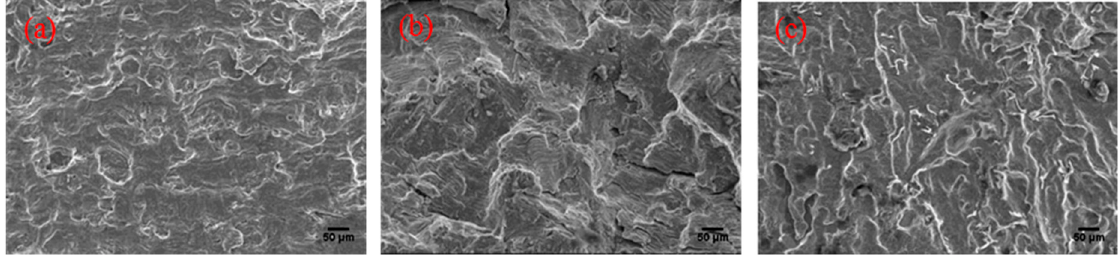
Figure 9. SEM morphology of longitudinal weld fusion line crack ( a ) initial crack zone; ( b ) propagation zone and ( c ) final fracture zone.